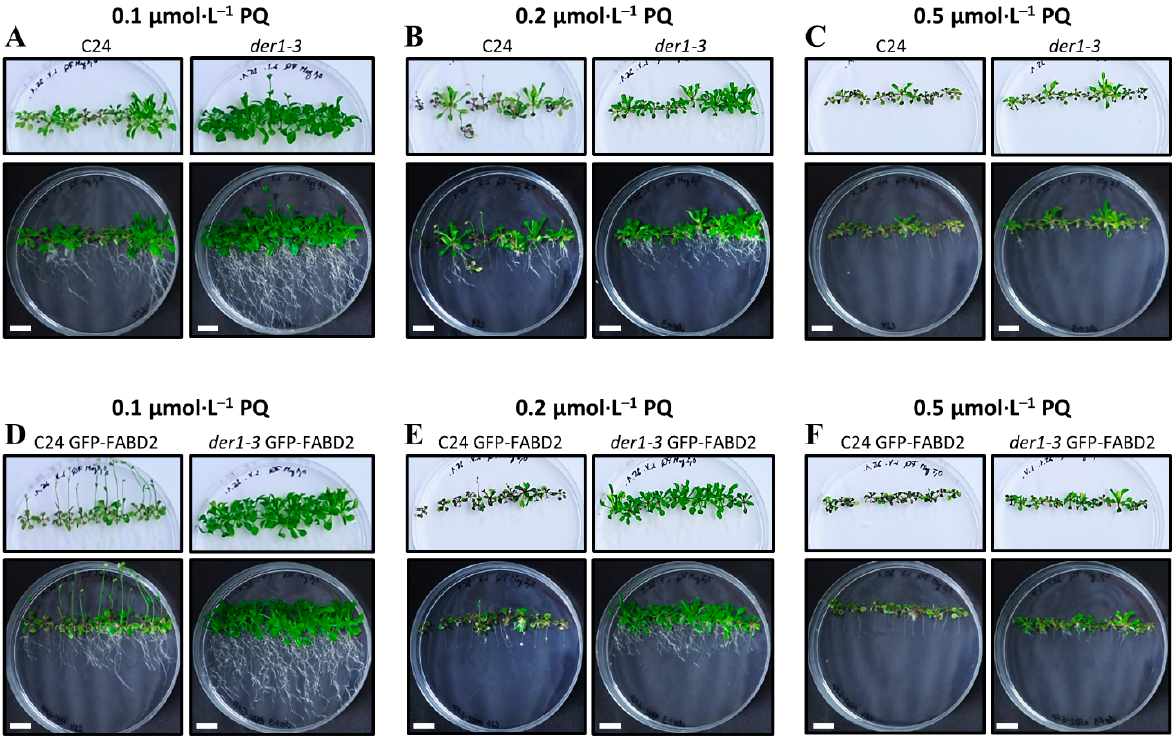
Figure 4. Plant phenotype of the control C24, der1–3 mutant and transgenic C24 and der1–3 lines expressing pro35S::GFP:FABD2 after their transfer to PQ-containing media. 3-day-old plants germinated on the control media were transferred to PQ-containing media and photographed 17 days after transfer. ( A – C ) Plants of the control C24 and der1–3 mutant growing on media containing 0.1 ( A ), 0.2 ( B ) and 0.5 ( C ) µmol·L − 1 of PQ. ( D – F ) Plants of the transgenic C24 line carrying GFP-FABD2 and transgenic der1–3 line carrying GFP-FABD2 growing on media containing 0.1 ( D ), 0.2 ( E ) and 0.5 ( F ) µmol·L − 1 of PQ. Aboveground parts of plants were photographed on a white background (upper row of images), and whole plants including roots were documented on a black background (lower row of images). Plants grown on the control media are documented in Figure S6. Scale bar = 1 cm.